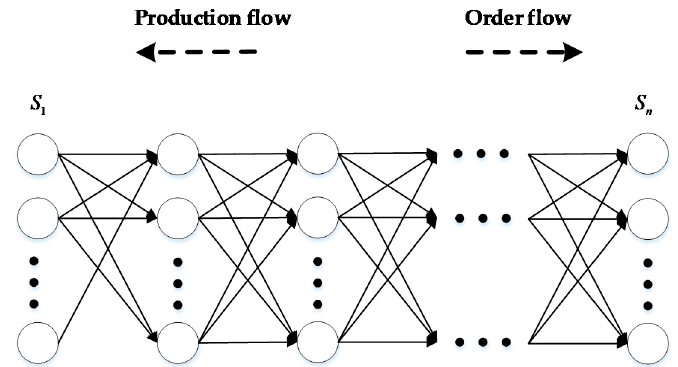
Figure 2. Supply chain network framework.